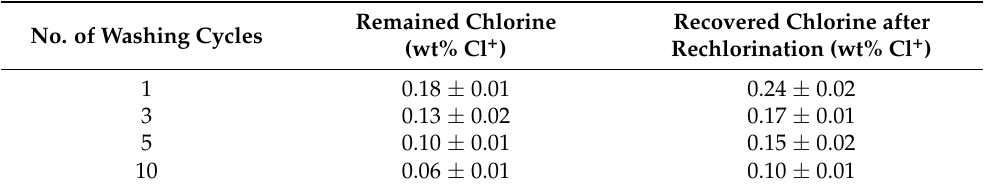
Table 2. Washing stability and rechargeability of the biocidability of cyclic imide N -halamine